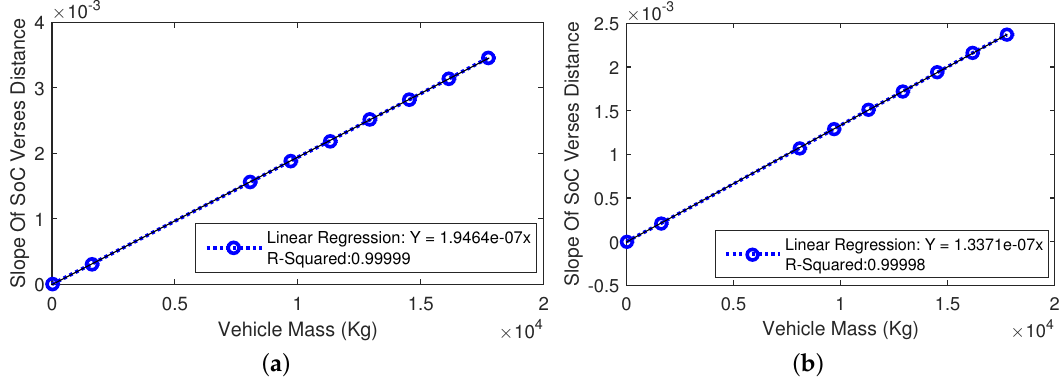
Figure 2. Slope of SoC versus distance w.r.t the gross mass of the vehicle: ( a ) SORT 3; and ( b )